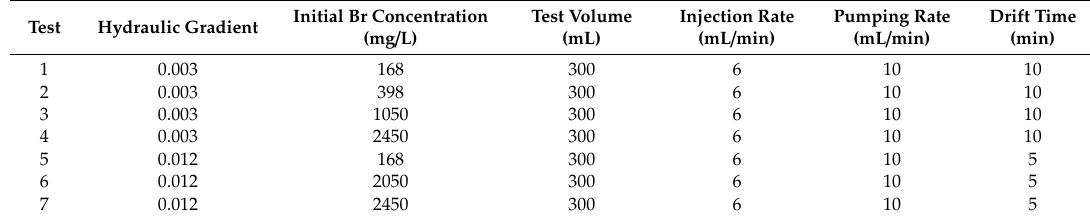
Table 2. Tracer test conditions for various